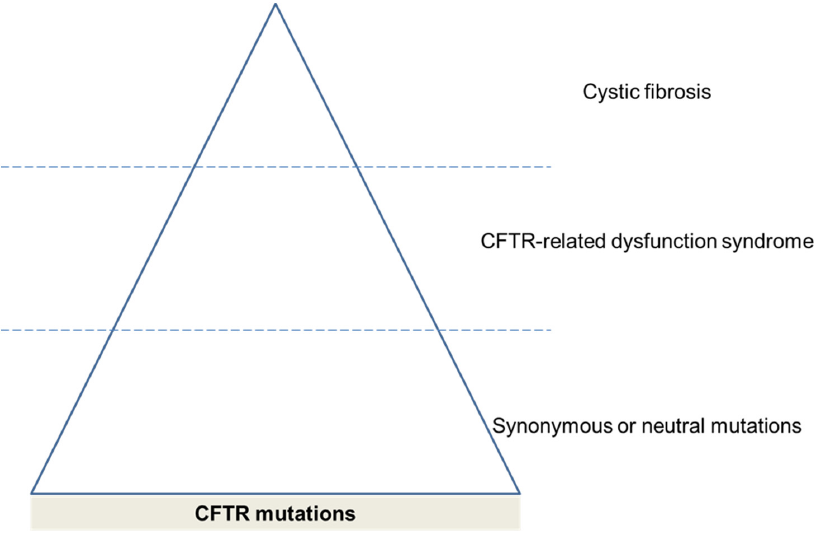
Figure 2. Classification of diseases as CFTR-related disorders.